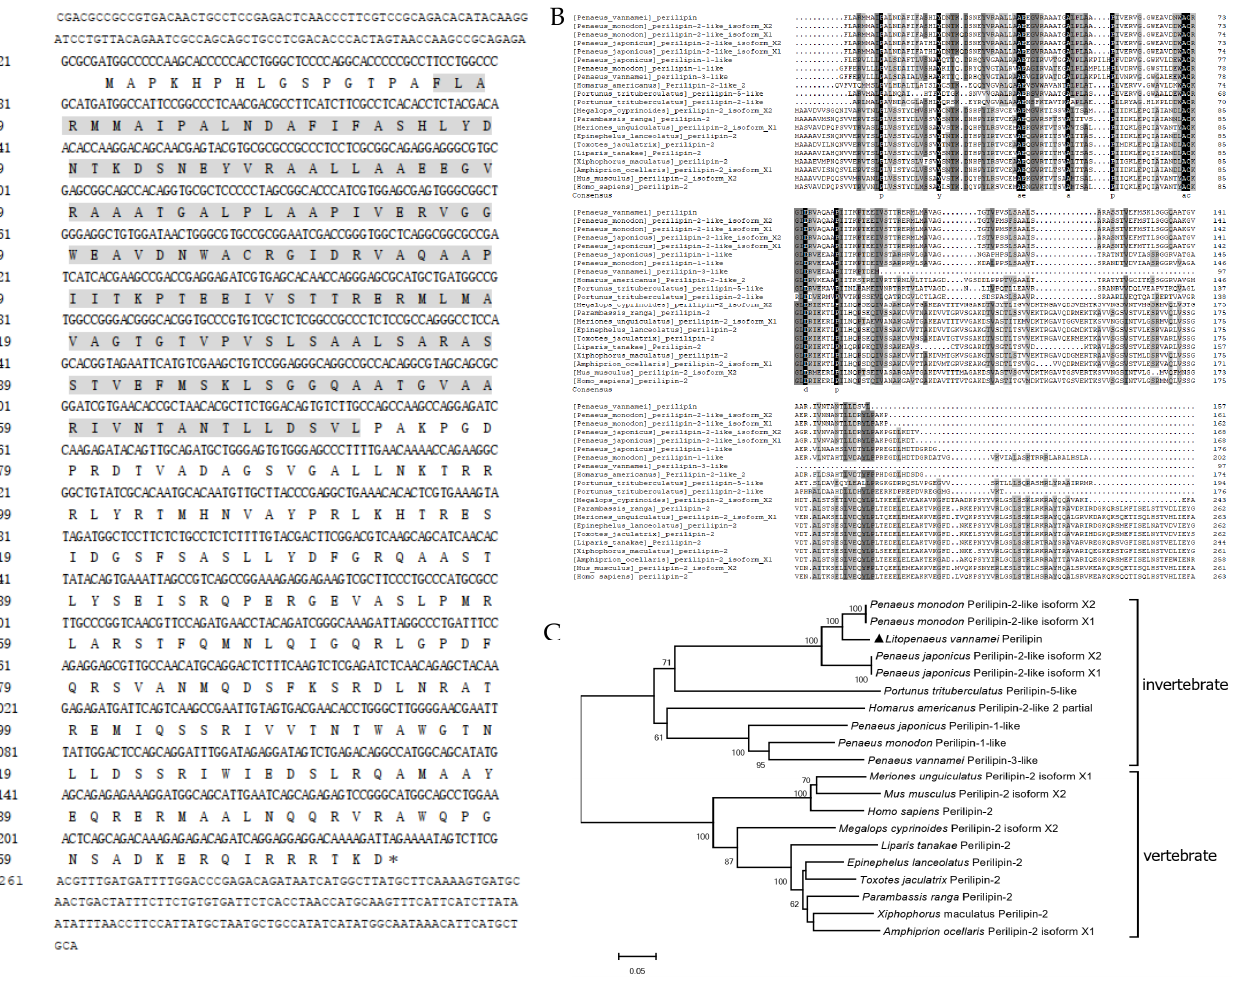
Figure 1. Sequence analysis of Lv Perilipin. ( A ) Nucleotide and deduced amino acid sequence of Lv Perilipin. The Perilipin characteristic domain (residues 16-172) was indicated with a grey shadow. ( B ) Multiple sequence alignment among Perilipin of L. vannamei and other species. ( C ) Phylogenetic analysis based on the amino acid sequences of Lv Perilipin. Protein sequences of different species were listed below: L. vannamei Perilipin (ON745208), Penaeus monodon Perilipin-2-like isoform X2